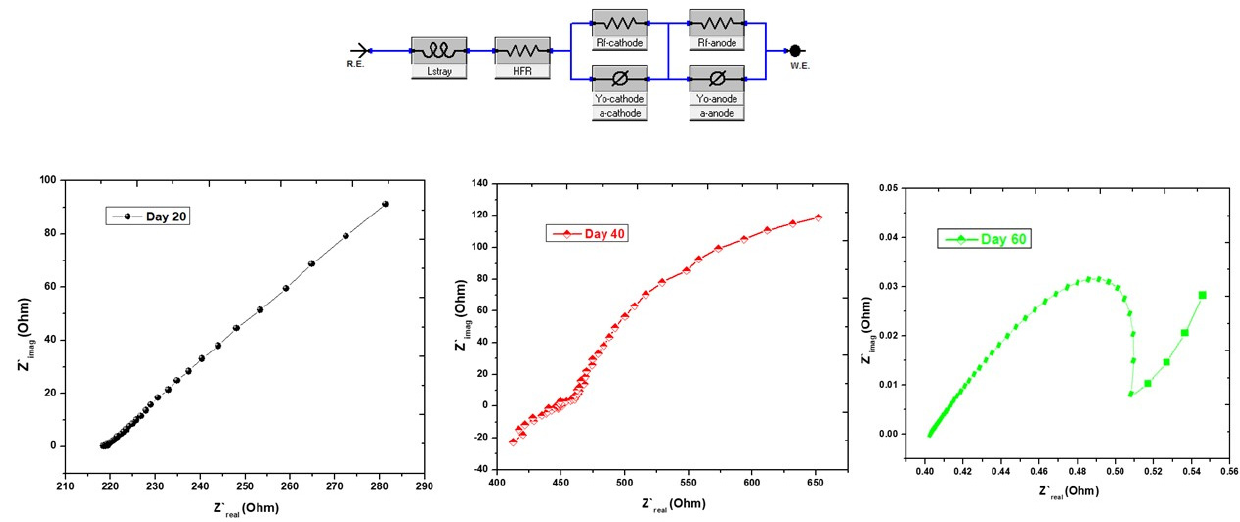
Figure 4. An EIS analysis of the MFC operation on the 20th, 40th and 60th days.